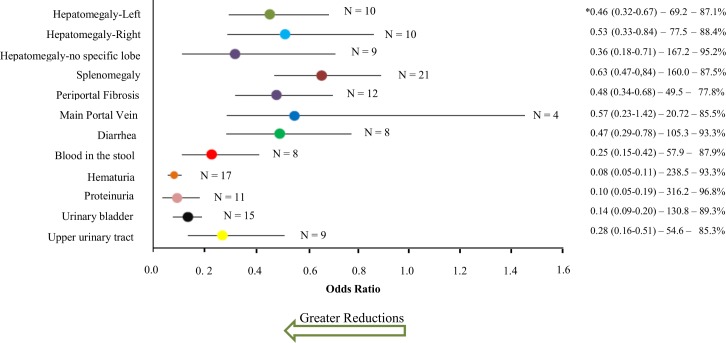
Odds ratios for morbidities related to schistosomiasis after treatment.Color circles indicate summary odds ratios estimated by random effects meta-analysis for morbidity prevalences after treatment, as compared to pre-treatment levels. The (N) by each line indicates the number of studies included in that meta-analysis. *These numbers indicate, respectively, the odds ratio and its 95% confidence interval, the Cochran χ2 value (where all χ2 values had P < 0.001), and Higgin's and Thompson's I2 statistic for heterogeneity estimation among the studies in each meta-analysis. Corresponding Forest plots of included studies and their summary statistics are included in Supplemental Information file S1 Fig.